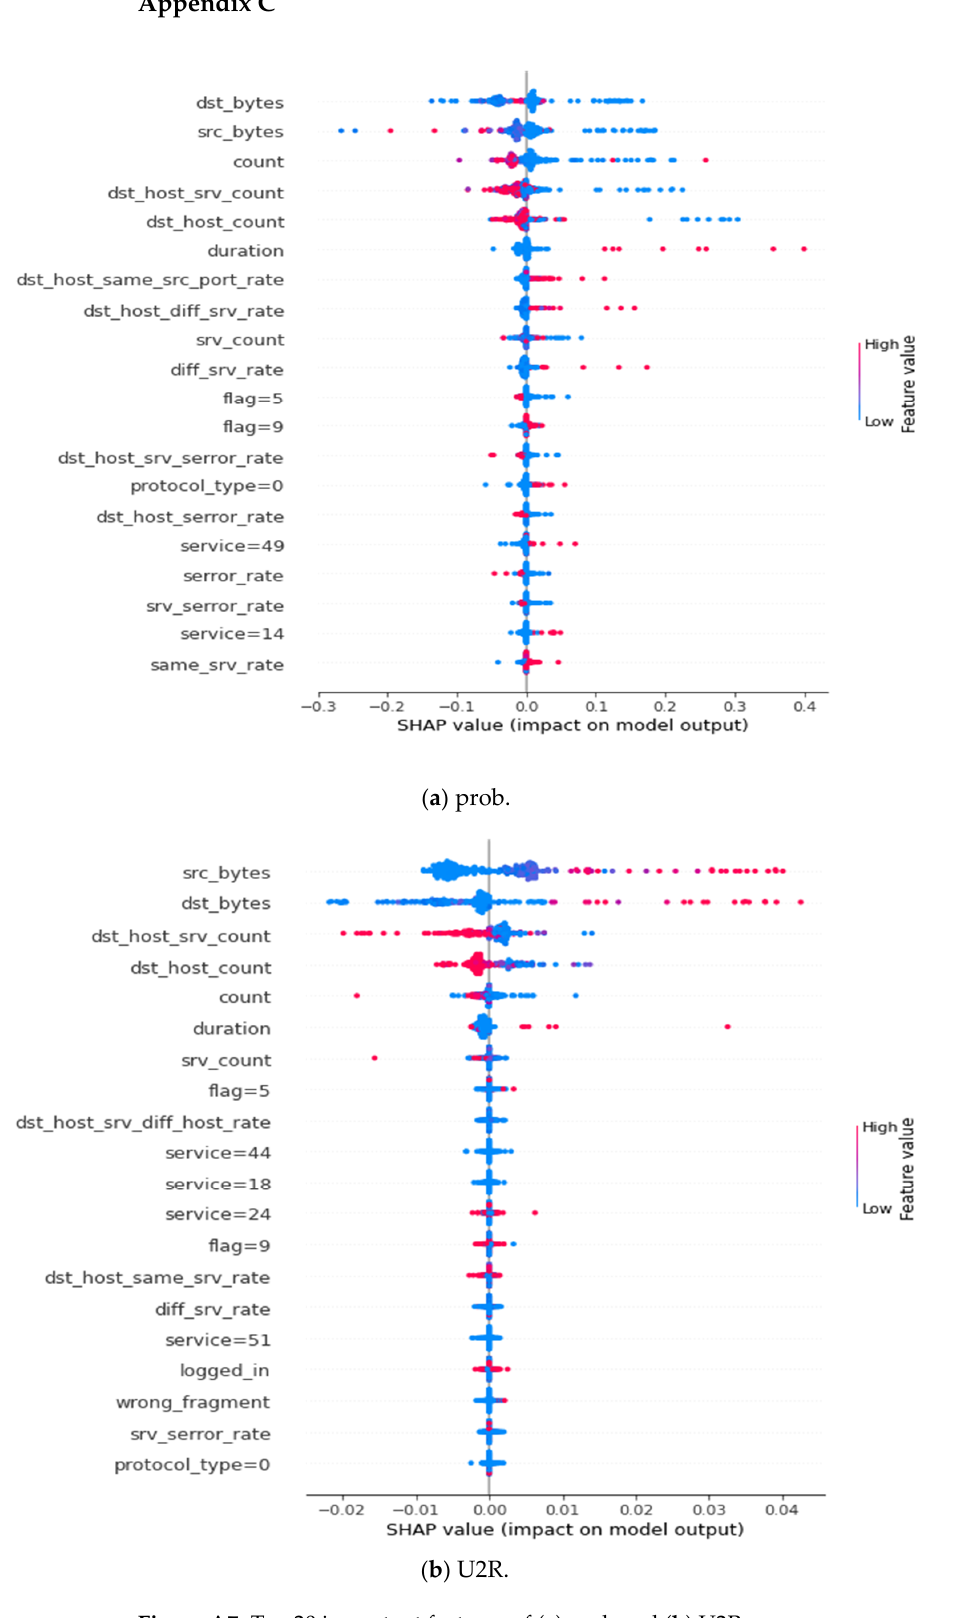
Figure A6. Top 20 important features of ( a ) DOS and ( b ) R2L.